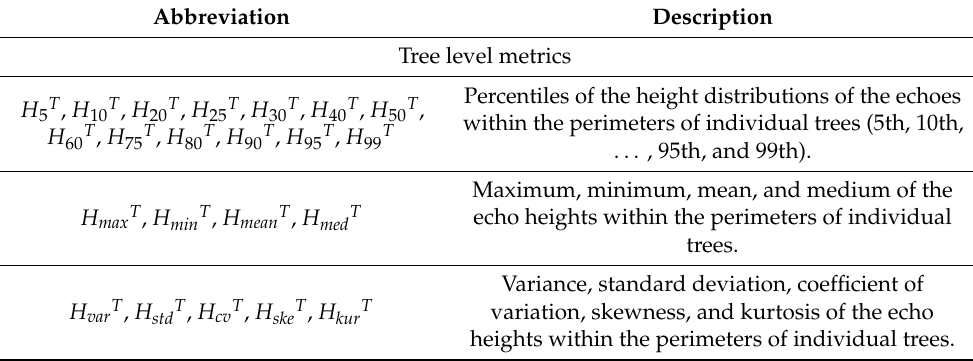
Table 3. Summary of the tree- and stand-level metrics derived from UAVLS data that were used for DBH